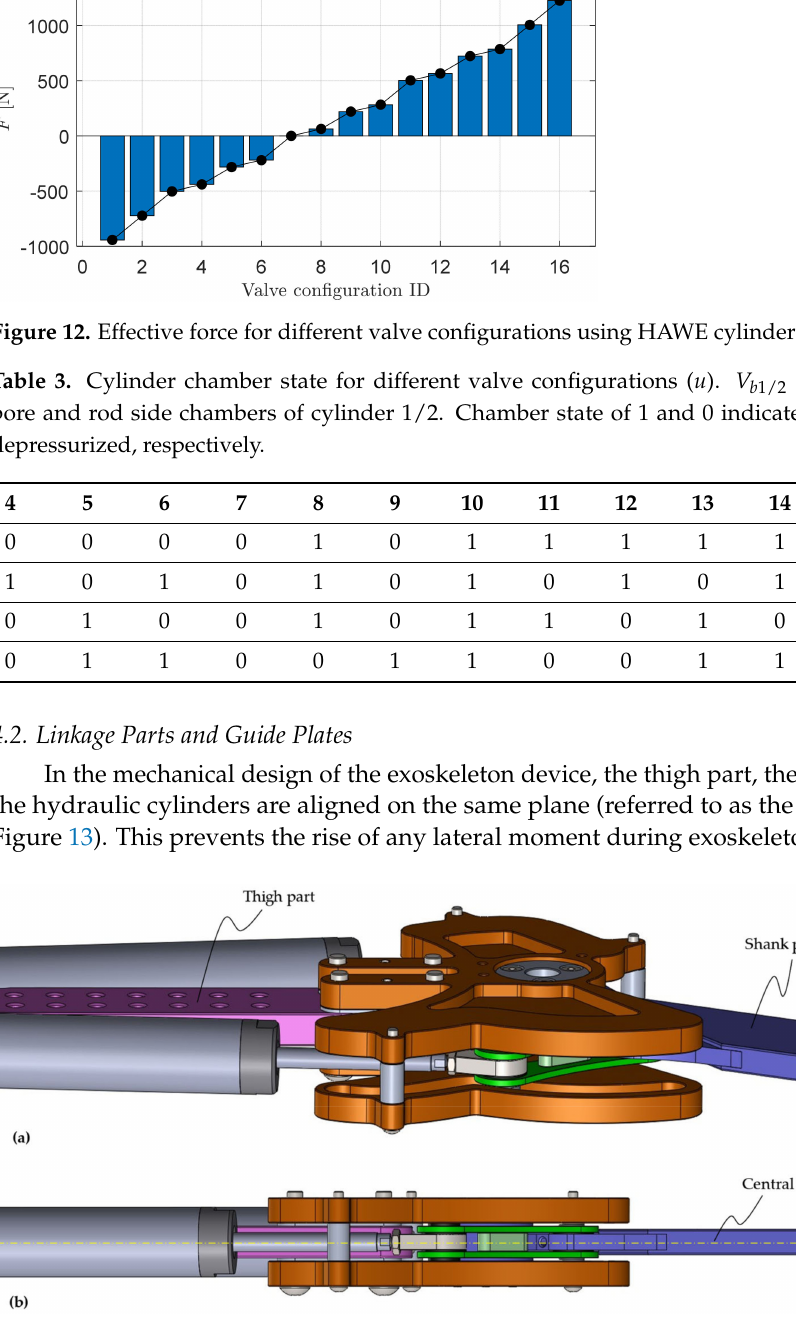
Figure 13. Illustration of the central plane and coplanarity of different linkages: ( a ) tilted view of the design; ( b ) bottom view of the design indicating the coplanarity of the thigh (magenta), cylinder (grey), and shank (blue)